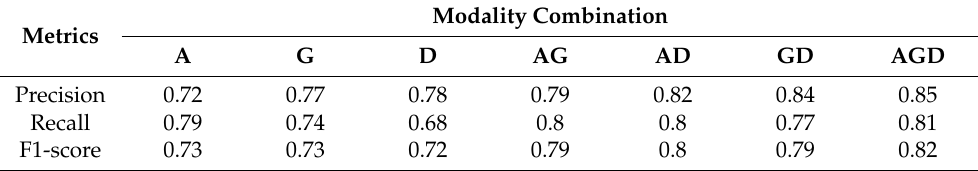
Table 5. Average testing precision, recall, and f1-score achieved using feature sets from different combination of modalities. LOSO evaluation. A—accelerometer, G—gyroscope, D—deep learn- ing output.